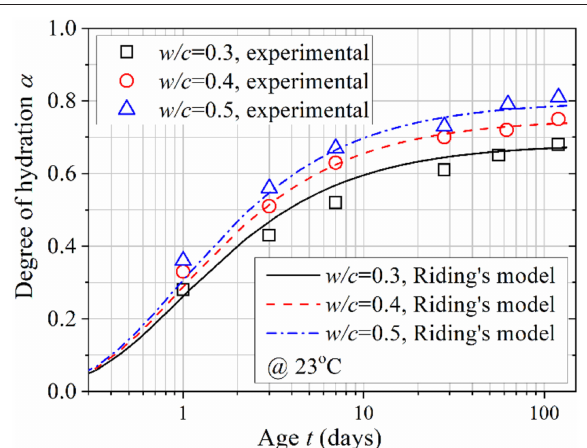
FIGURE 2 | Evolution of CH mass fraction following degree of hydration.